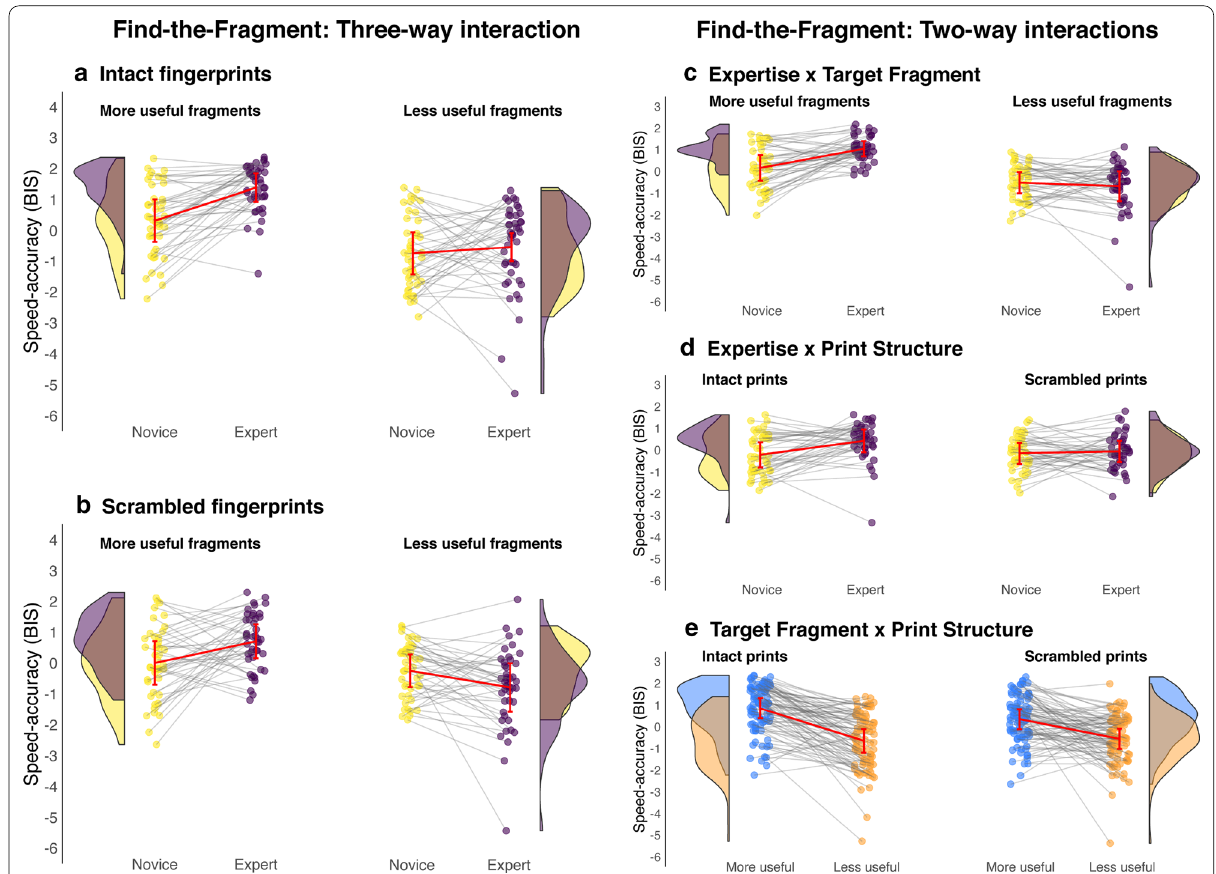
Fig. 3 A visualization of the interactions for the speed–accuracy data (measured using Balanced Integration Scores) in the Find-the-Fragment task. We present the three-way interaction (left) comparing experts and novices for each fragment type for the intact trials ( a ) and scrambled trials ( b ). We also present all three two-way interactions ( c – e ). In all but panel e , the expert data are colored purple and the novice data yellow. Each participant’s individual performance is represented by the small circles, with grey lines connecting every expert to their yoked novice ‘twin’. The distributions depict the overlap in each group’s performance, the red error bars represent the confidence interval around each cell mean and a red line connects the group means for each cell. Panel E depicts the final two-way interaction comparing performance at finding more useful features (blue) and less useful features (orange) with each participant’s data connected by a grey